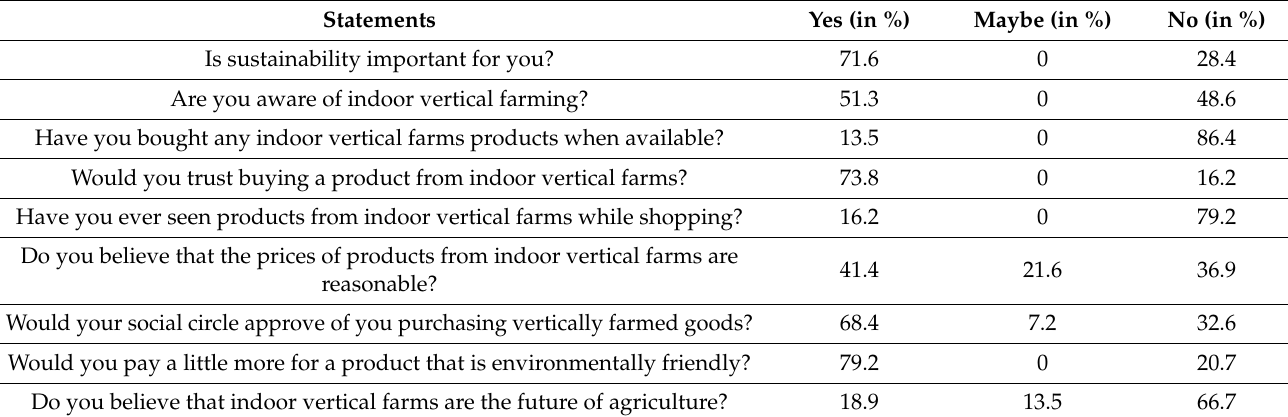
Figure 2. Visual summary of the demographic characteristics of the participants in this study. Table 1. Consumer/Public responses concerning the general attitude around